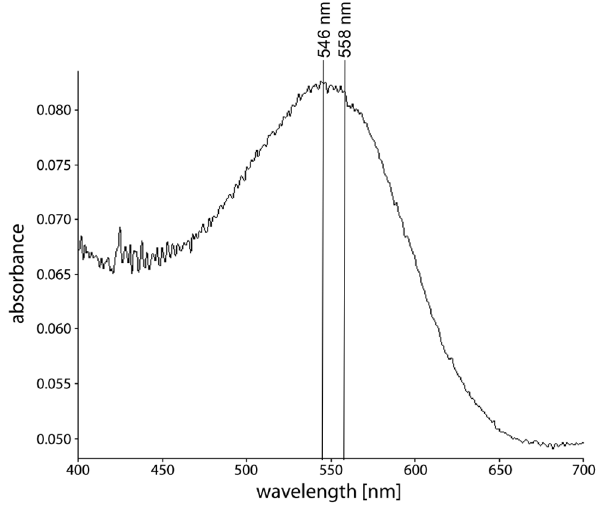
Figure 3. Absorption spectrum of dark-adapted bR nanodiscs. An absorption spectrum of bR nanodiscs was recorded. The absorption maximum of about 550 nm indicated correctly folded bR. The spectrum showed a maximum at 546 nm indicating bR to be predominantly in the monomeric state, whereas a maximum at 558 nm would have indicated a trimeric state.